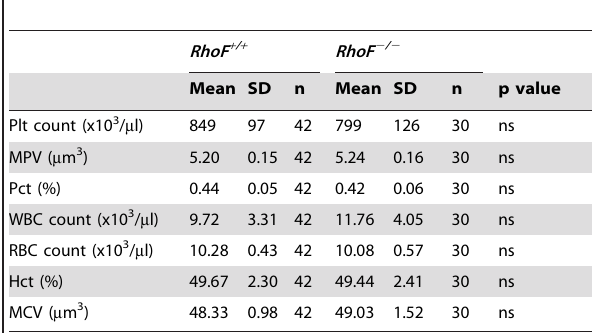
Table 1. Summary hematologic data for wild type and RhoF 2 / 2